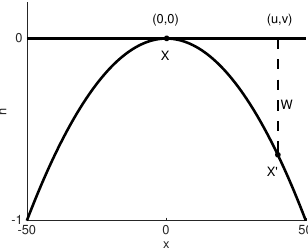
Figure 2: The local surface is shown by a quadratic curve. The coordinate system is defined in the way that point X is the origin, ( u, v ) are the basis vectors in tangent space and n is the basis vector in normal direction. Therefore, every point X (cid:48) can be rep- resented as [ u X (cid:48) , v X (cid:48) , W ( u X (cid:48) , v X (cid:48) )] (cid:62) . sparsity of the sampled points. It is also preferable to change the neighborhood based on the geometry of the sampled